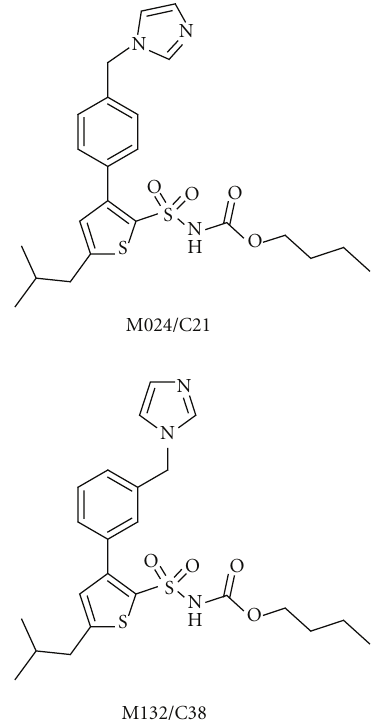
Figure 5: The structures of the selective AT2 receptor agonist M024/C21 and the structurally similar M132/C38, which acts as an AT2 receptor